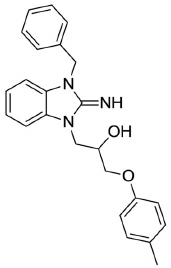
SCHEME 1 | Synthesis of theVU573